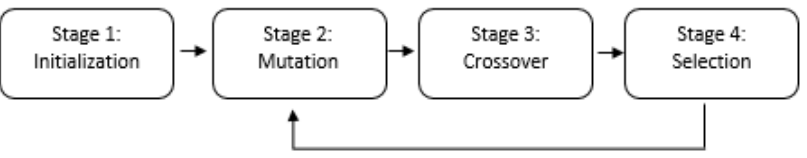
ff erential Evolution (DE) optimization